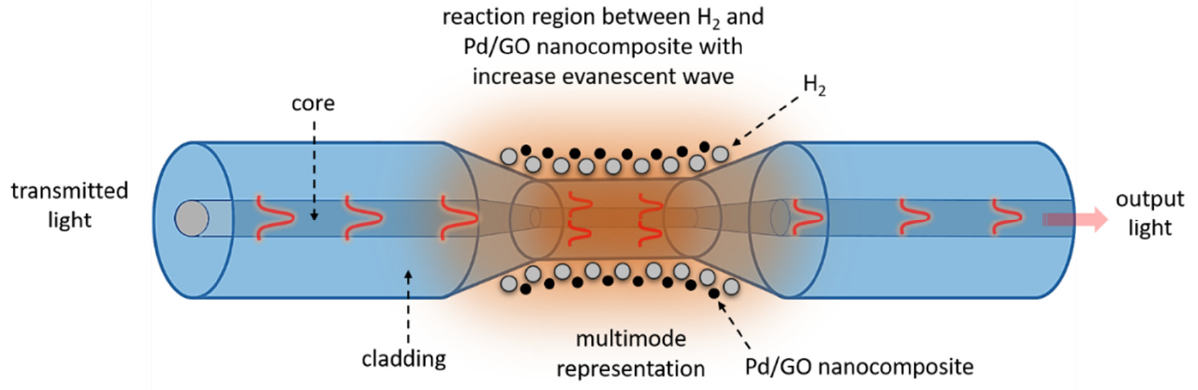
Figure 20. Illustration of gas-sensing mechanism between the H 2 molecules and Pd/GO nanocom- posite on tapered optical fiber.